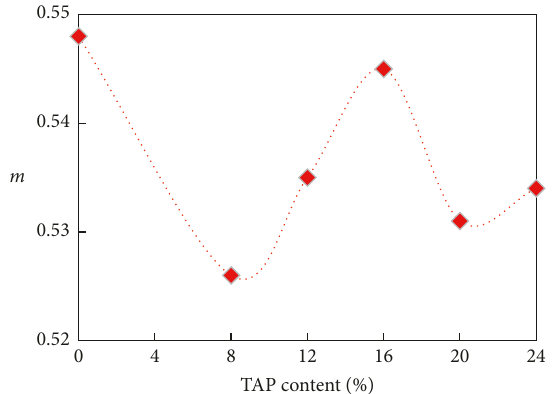
Figure 13: Creep rate of modified asphalt with different TAP